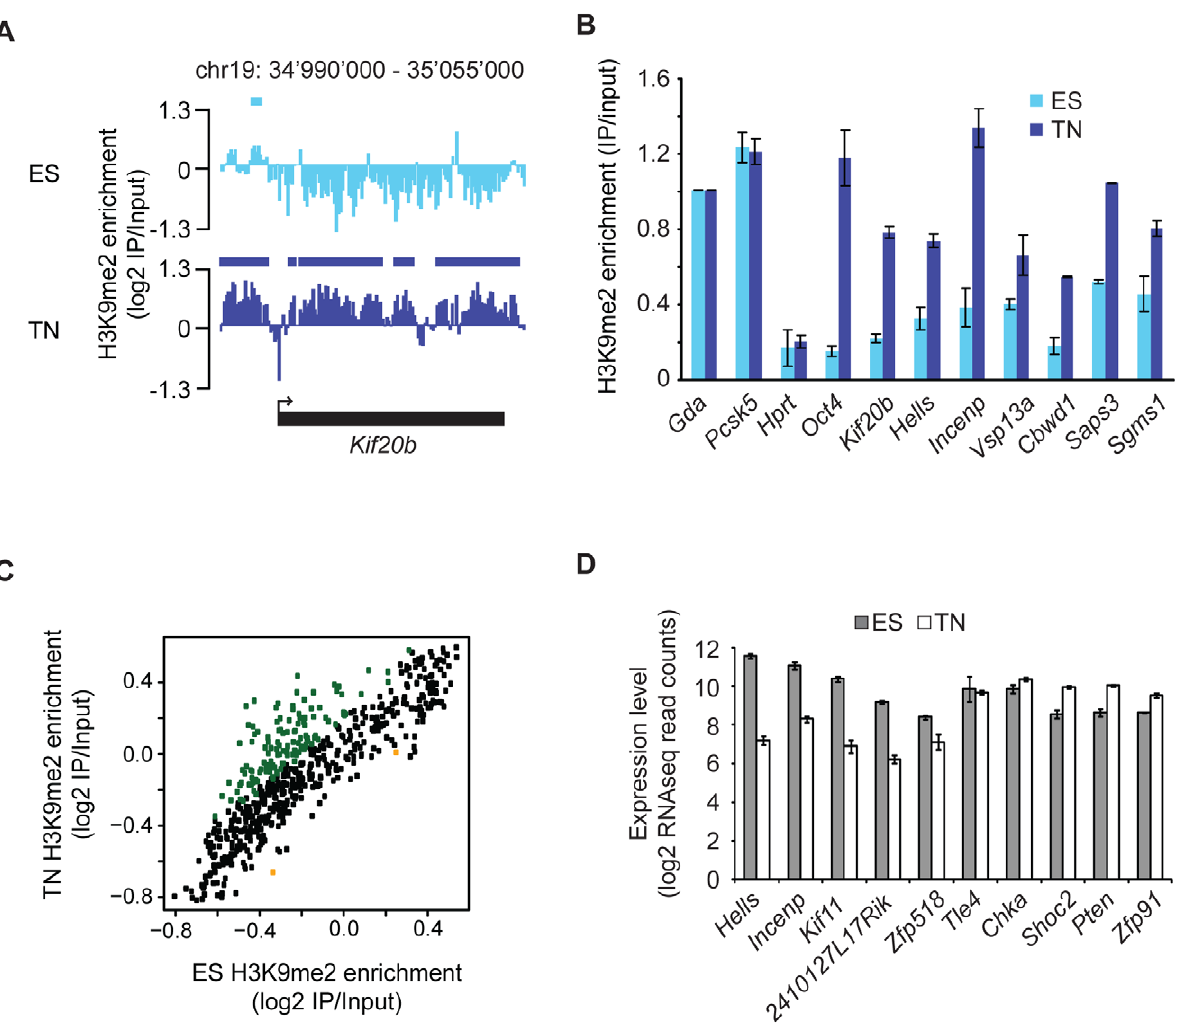
Figure 2. Changes in H3K9me2 during differentiation occur localized and at gene bodies. (A) H3K9me2 signal at the Kif20b locus as an example of a locus, which gains H3K9me2 in neurons. Bars above each track indicate HMM-defined H3K9me2 domains. (B) Validation of microarray results by single gene PCRs for a set of gene bodies that gain H3K9me2. Enrichments were normalized to Gda . Both Gda and Pcsk5 have equally high H3K9me2 levels in both cellular states in the array data. Methylation levels of Hprt (negative control) and Oct4 ( Pou5f1; positive control [39]) were measured at the promoter. Shown are averages from 2 independent differentiation experiments. Error bars indicate standard deviation. (C) Comparison of H3K9me2 enrichments in gene bodies in ES cells and neurons. Genes, which gain and lose H3K9me2 significantly (adjusted P-Value , 0.05) are depicted in green and orange, respectively. (D) RNAseq read counts of 10 genes that show the most significant gain of H3K9me2. Black and white bars indicate RNA in ES cells (ES) and neurons (TN),